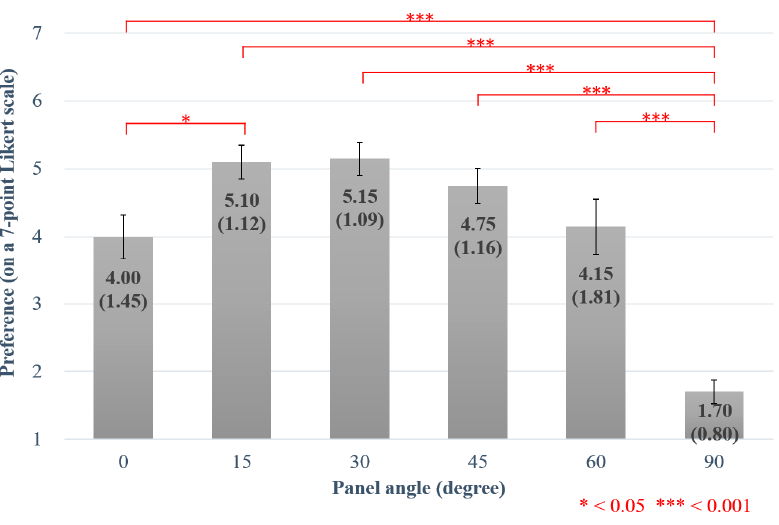
Figure 5. Preference ratings with the results of post hoc multiple comparisons.